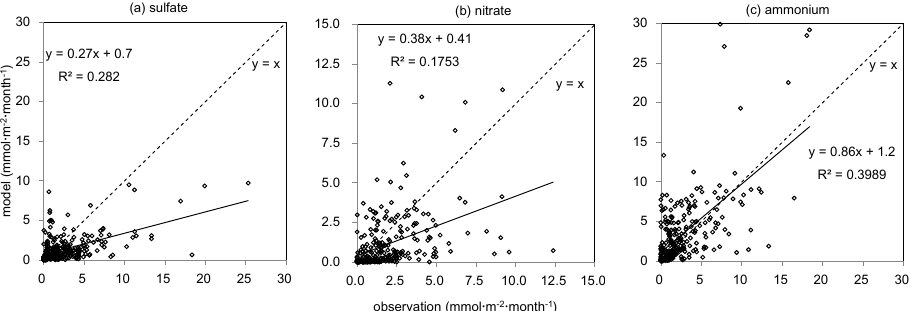
Fig. 7. Scatter plots of simulated (y-axis) versus observed (x-axis) SNA wet deposition fluxes. The square of correlation coefficient ( R 2 ) and the normalized mean bias are